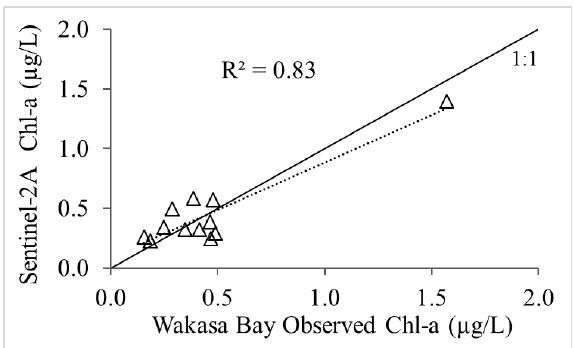
Figure 7. Observed and Sentinel-2A derived chlorophyll-a for Wakasa Bay (4 August 2018).